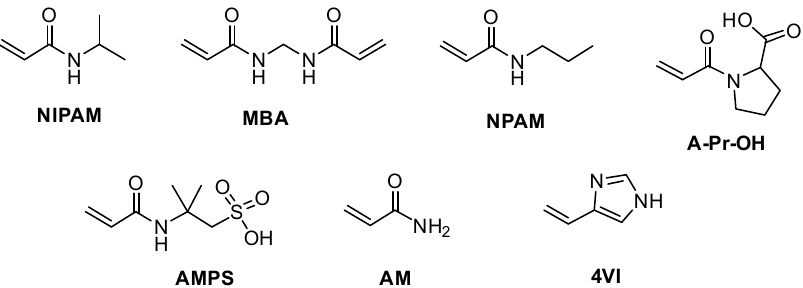
Figure 1. Monomers and crosslinker used in the preparation of nanogels.